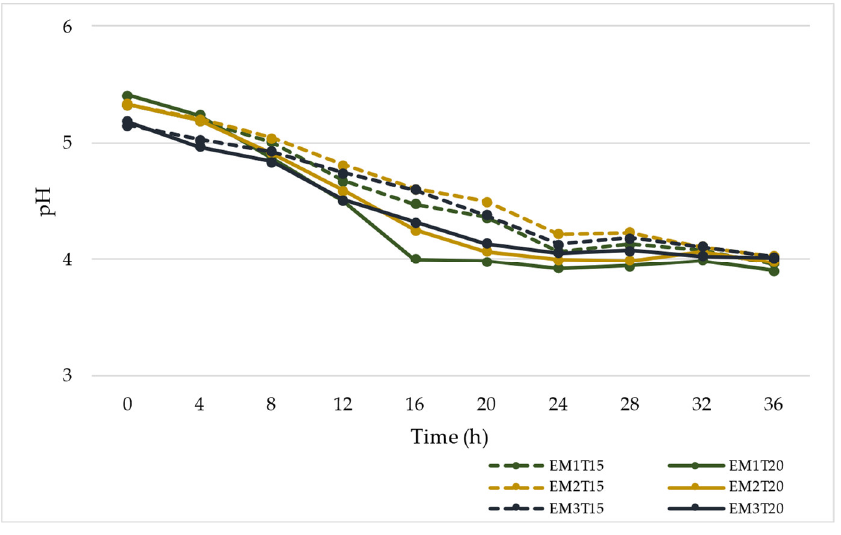
Figure 2. Average pH of mucilage of coffee with prolonged fermentation.